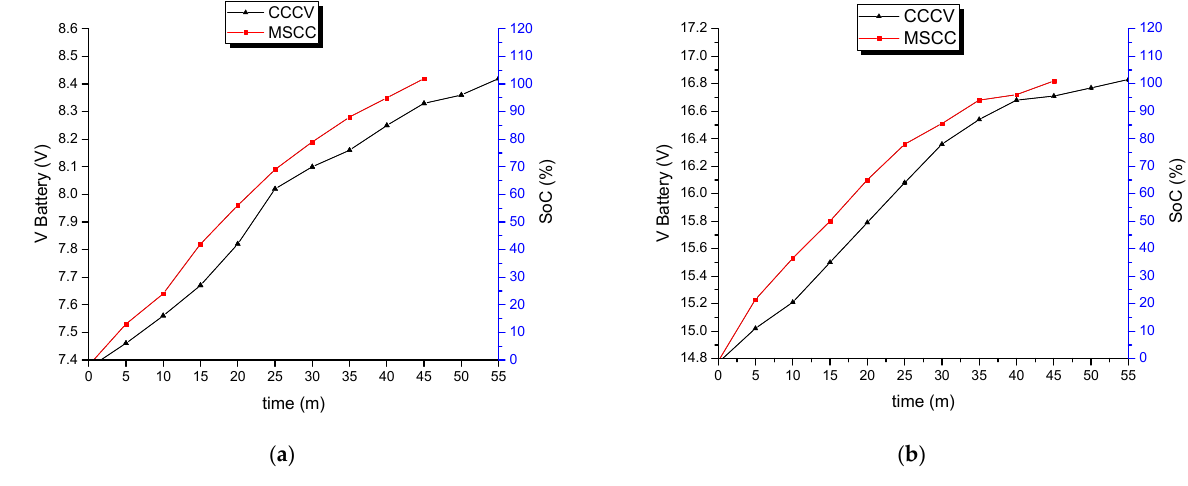
Figure 14. Battery voltage: ( a ) 2S; ( b ) 4S .